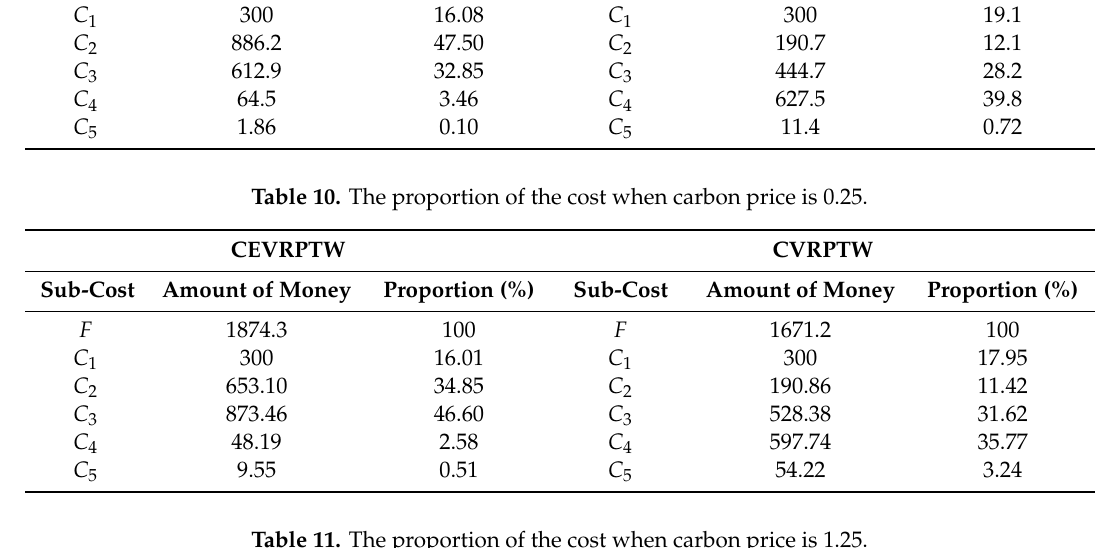
Table 11. The proportion of the cost when carbon price is